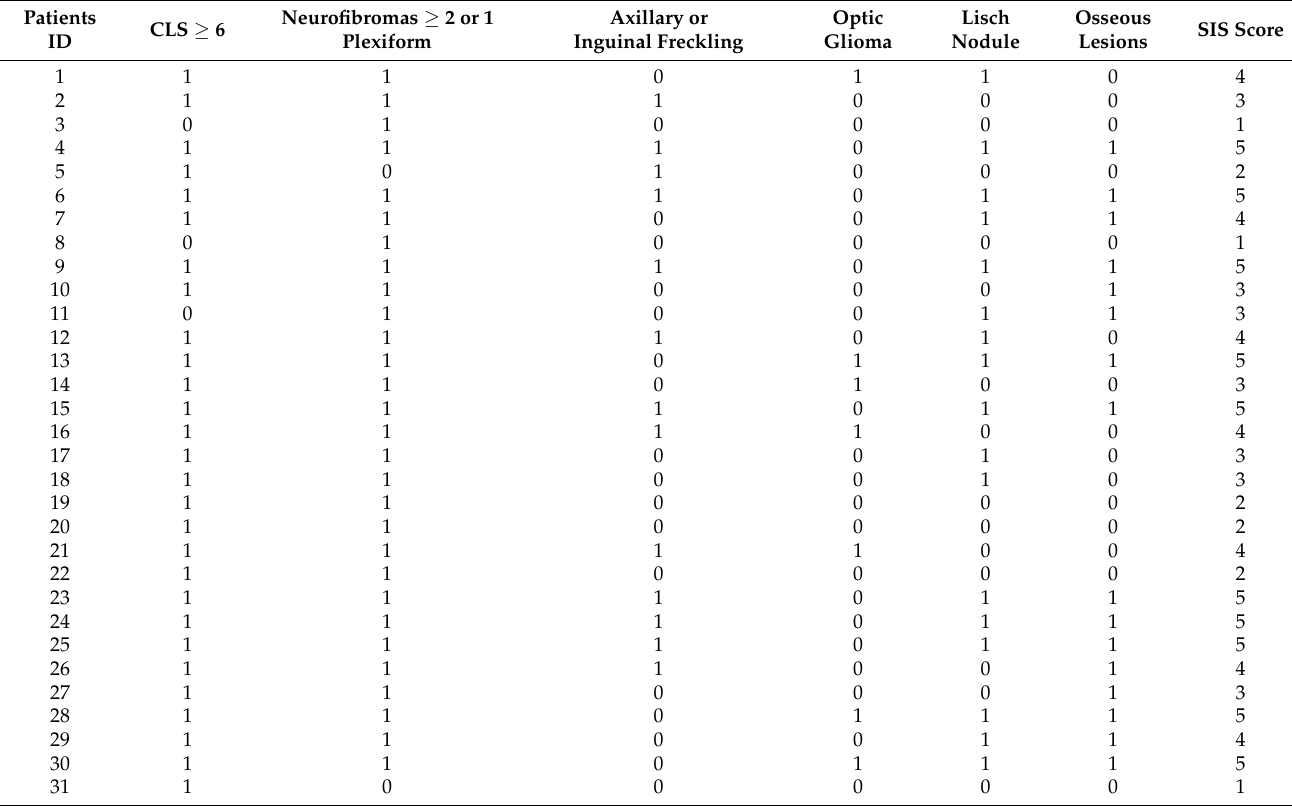
Table 3. Severity index score (SIS) score for each